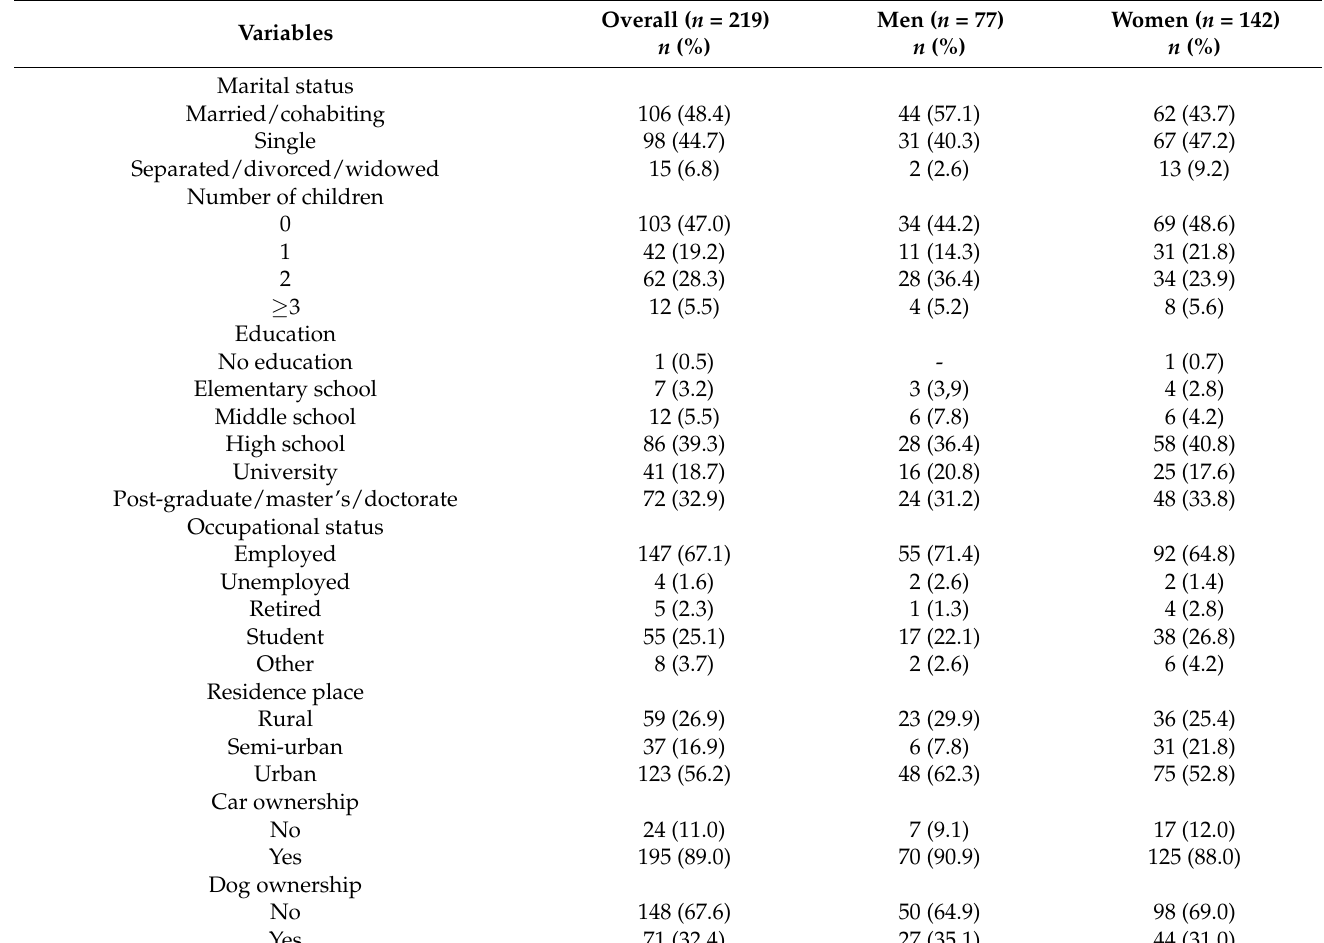
Table 2. Demographic data documented by